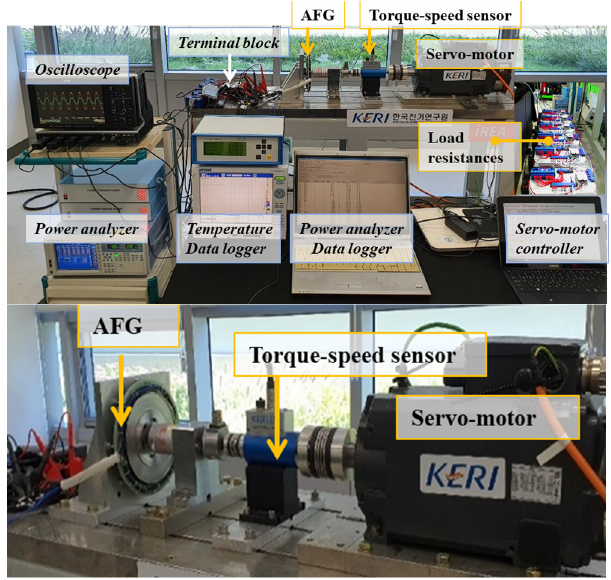
Figure 13. TEST set for the AFPM generator.